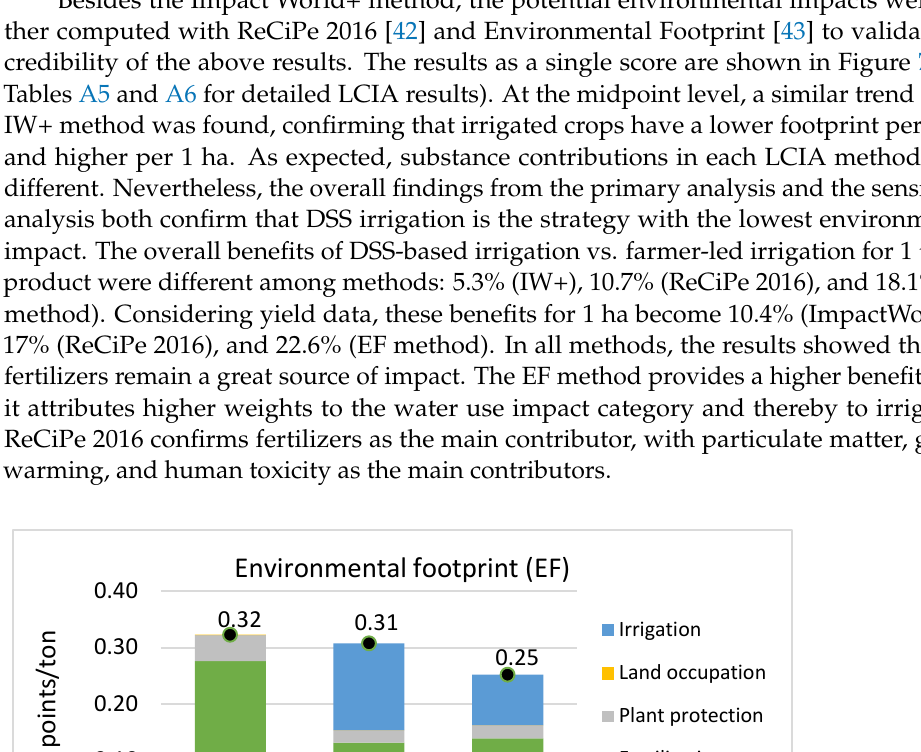
Figure 7. Process contribution to the overall environmental impact of olive cultivation as single score (points) using EF 3.0 (adapted) and ReCiPe 2016 life cycle assessment methods. 4. Conclusions This is one of the few LCA studies performed so far for table olive growing systems in Greece. Along with the numerical reference for Greek olives, it provided a better un- derstanding of the benefits of using DSSs for irrigation management. The results were studied for two functional units, a mass-based (reflecting production efficiency) and a surface-based unit (reflecting production intensity). The large increases in yield resulting from irrigation offset the increases in footprint due to increased resource inputs compared to the rainfed system. This confirmed that high-yield farming reduces the global environ- mental impact compared to low-yield olive farming systems. On the other hand, irrigated orchards are likely to increase impacts per unit area of farmland. The use of DSS-based irrigation compared to conventional farmer practices allowed achieving a considerable decrease in water and electricity use of about 42.1%. This reduced the total environmental impacts of the irrigated process by 40% per unit of product and 43% per unit area. How- ever, environmental benefits were drastically reduced when considering all agricultural activities. This is because fertilization was the highest contributor to environmental im- pacts. Overall, this assessment showed that the total environmental impact could be re- duced by 5.3% per 1 ton and 10.4% per 1 ha by changing from conventional to smart irri- gation practices. A sensitivity analysis of the LCA method demonstrated that benefits could be higher. This highlights that promising environmental benefits could be achieved using DSS-based irrigation, which can reduce impact intensity and increase efficiency due to more efficient use of inputs. To further enhance the life cycle environmental benefits, the focus should be placed on the development of DSSs optimizing both irrigation and nutrient management. Further studies will be conducted to analyze the sustainability as- pect of smart technologies considering cross-cutting economic, environmental, and social effects.